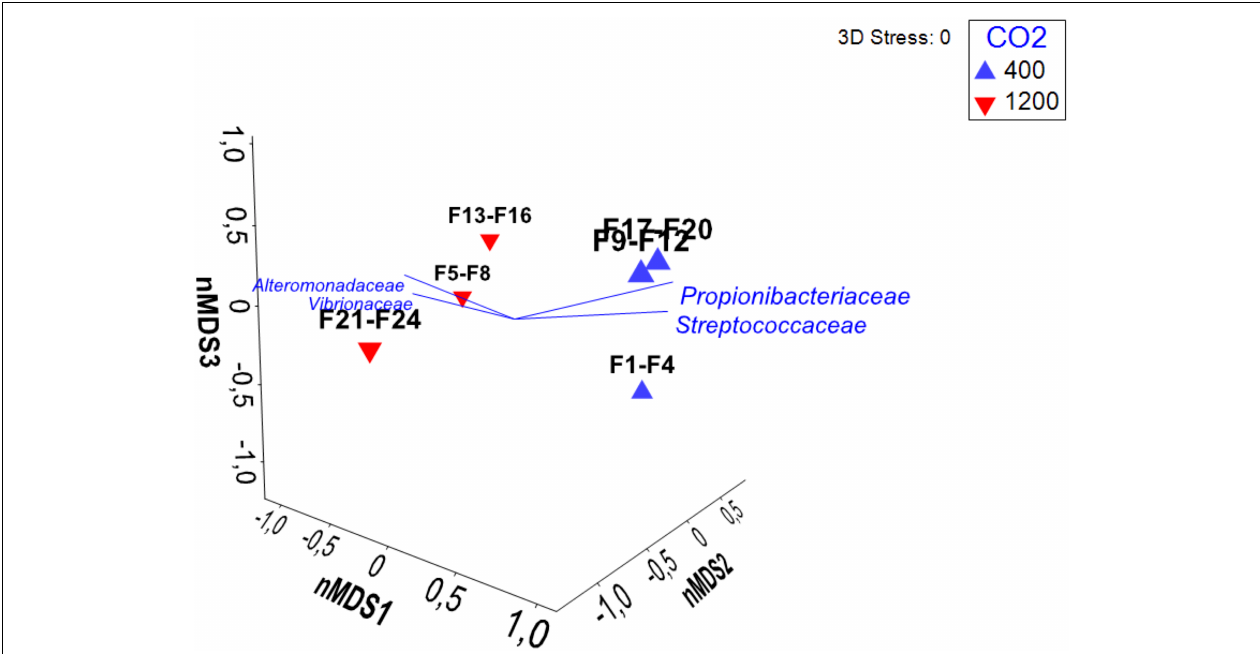
FIGURE 2 | Non-metric multidimensional scaling (nMDS) plot based on Bray–Curtis similarity among microbial communities of S. aurata intestinal fluid samples, obtained from fish grown at 400 µ atm CO 2 (F1–4; F9–12; F17–20) and at 1200 µ atm CO 2 (F5–F8; F13–F16; F21–F24). The plot shows a clear change in community structure with the increase in pCO 2 ( p = 0.022, Monte–Carlo test). The vectors displayed indicate those OTUs identified as contributing most strongly toward microbiota similarity of samples from the same experimental group using SIMPER analysis. The vector direction for each OUT reflects the Pearson correlations of their square-root transformed counts with the two ordination axes, and length gives the multiple correlation coefficient from this linear regression on the ordination